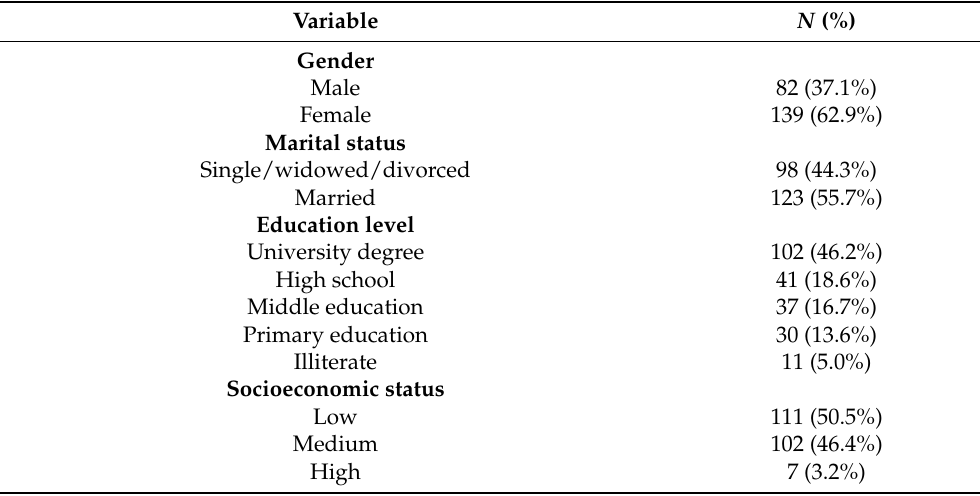
Table 1. Sociodemographic and other characteristics of the participants ( N =